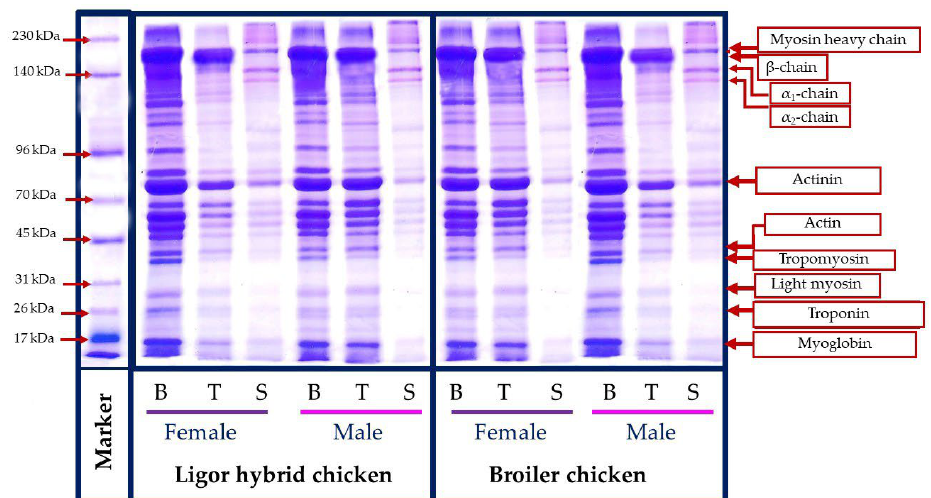
Figure 3. Protein patterns of breast, thigh, and skin of broiler and Ligor hybrid chicken from different sex. B, breast; T, thigh; S, skin female.